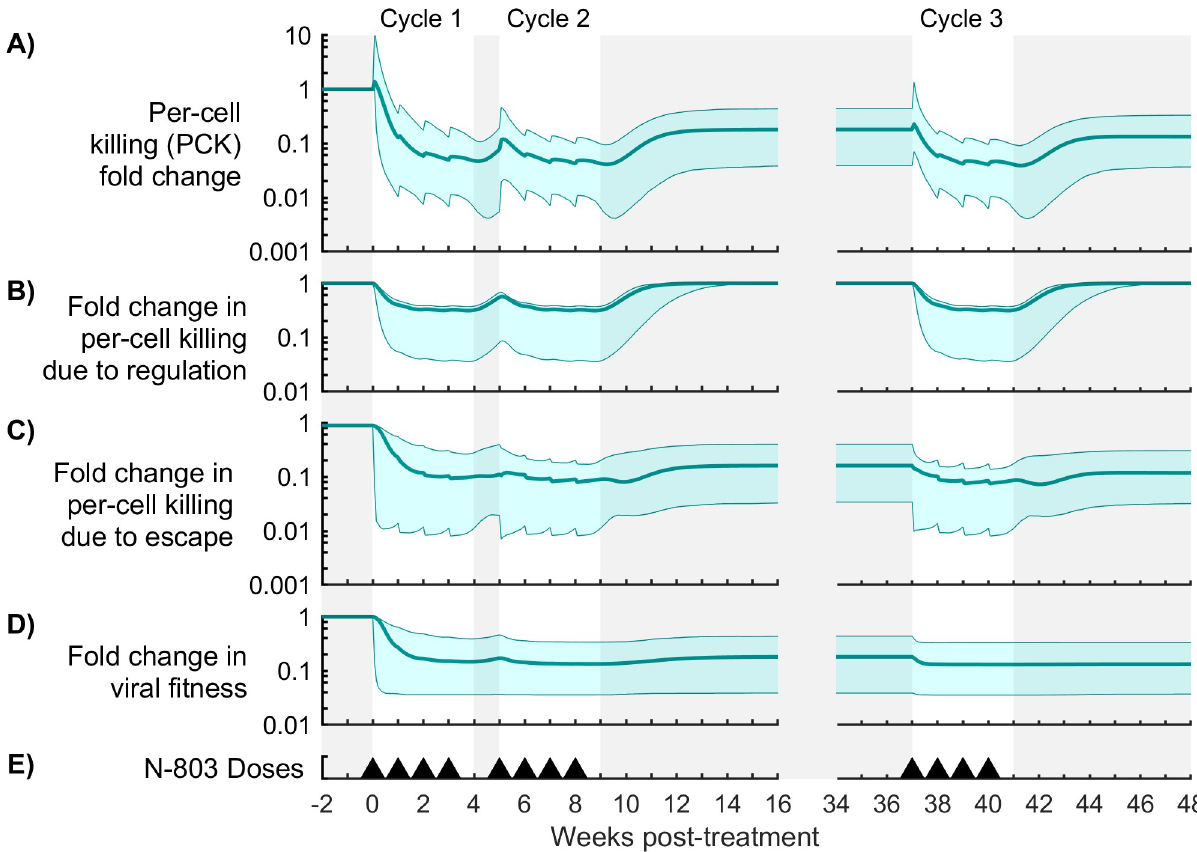
Fig 6. Contributions of immune regulation and viral escape to per-cell killing (PCK) for Model #1. Shown are measures of mechanism contribution for the model with immune regulation and viral escape (model #1). Panel (A) shows the fold change in per-cell killing rate, or PCK (Eqs 22–24). Panels (B,C) show the effect of immune regulation and viral escape on PCK (Eqs 25 and 27). Panel (D) shows a measure of viral fitness (Eq 28). The bold line corresponds to the best-fit model, and the shaded region corresponds to the Bayesian 95% credible interval. Panel (E) shows timing of 0.1 mg/kg subcutaneous doses of